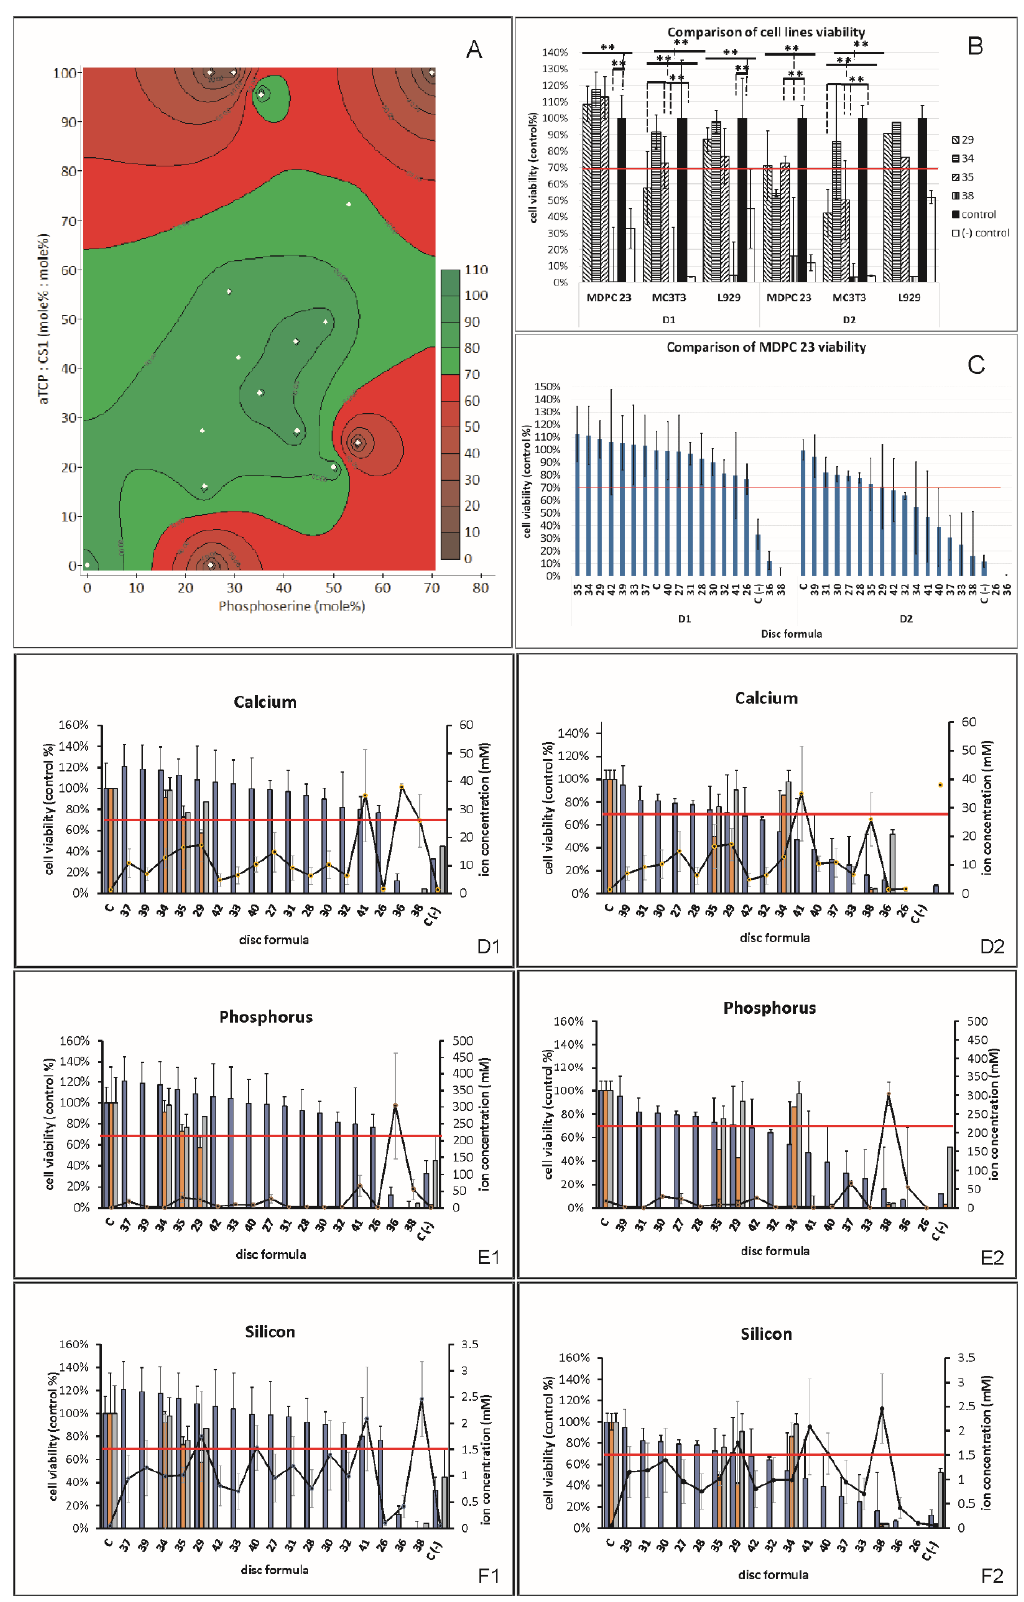
Figure 8. Cell viability in indirect contact with PMC extracts. ( A ) Formulation plot comparing MDPC23 viability (Z ‐ axis) after exposure to extracts for 24 h, with adhesive composition (X ‐ and Y ‐ axis). Regions in green indicate conditions that are cytocompatible (cell viability ≥ 70%), while red regions represent opposing extremes that are cytotoxic (cell viability ˂ 70%). ( B ) Viability of MDPC23 after 24 or 48 h of incubation with extracts, the red line indicates cytotoxicity according to ISO ‐ 10993 (<70%). ( C ) After narrowing formulation range, comparison of 24 and 48 h viability, be ‐ tween MDPC23, MC3T3 ‐ E1, and L929. ( D1 – F1 ) Overlay of viability, after 24 or 48 ( D2 – F2 ) hours of